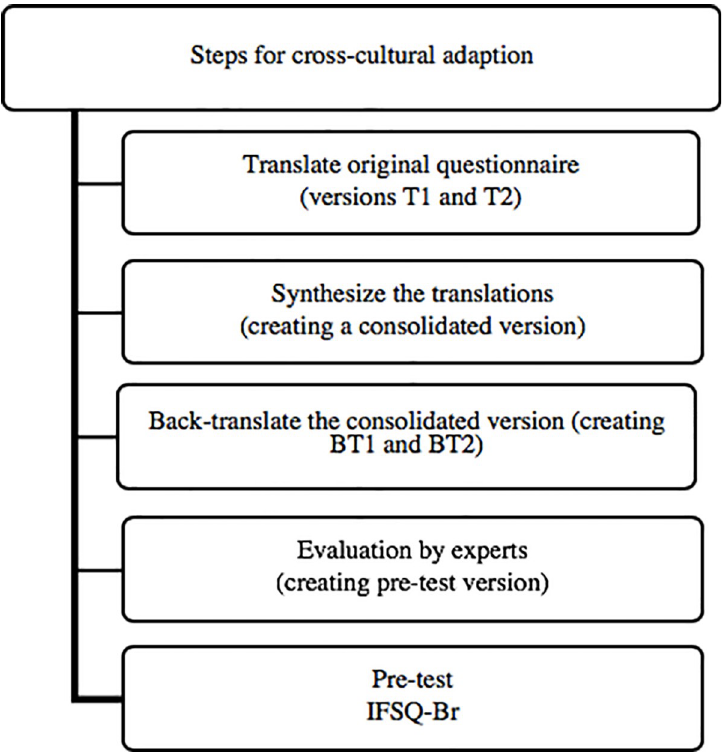
Fig 1. Steps for the cross-cultural adaptation and evaluation of the content validity of the Infant Feeding Style Questionnaire. Federal District, Brazil. 2018.